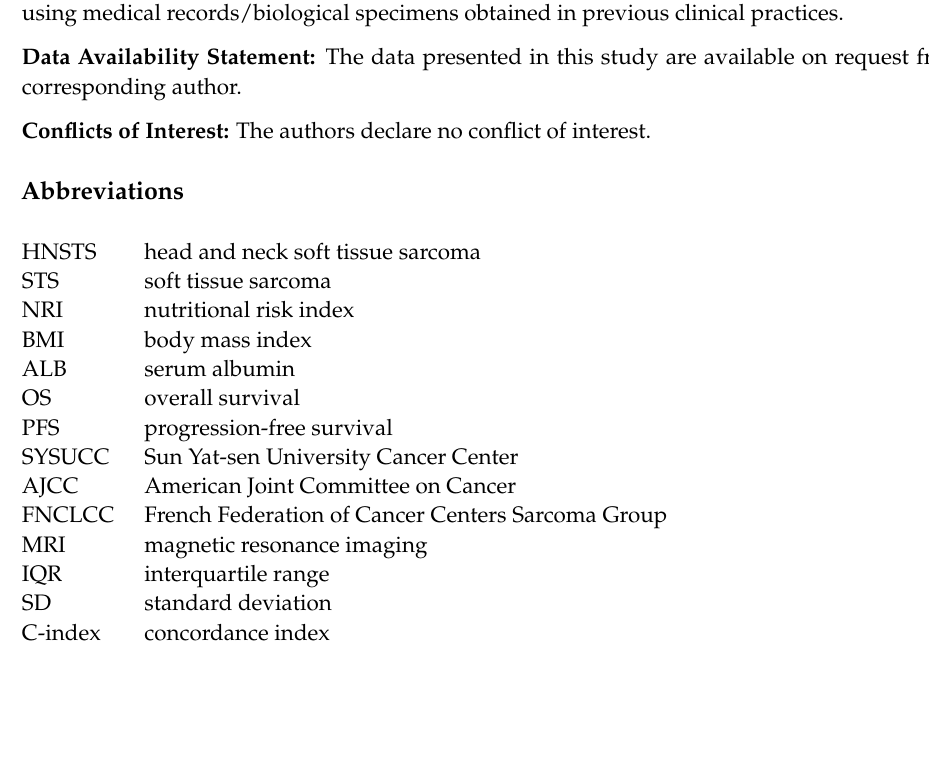
Figure S2: The maximum of the standardized log-rank statistics for NRI cut-off value; Figure S3: Calibration plot of OS (A) and PFS (B) at 3- and 5-year in the validation cohort; Figure S4: Predictive performance of nomogram for OS (A) and PFS (B) at 3- and 5-year, by time-dependent receiver operating characteristic (ROC) curve analysis; Figure S5: Progression-free survival (PFS) curves of subgroup analysis in HNSTS patients for different types of clinical manifestations according to NRI. (A) The PFS rate of patients with age ≤ 50; (B) The PFS rate of patients with age > 50; (C) The PFS rate of male patients; (D) The PFS rate of female patients; (E) The PFS rate of patients with low-risk site; (F) The PFS rate of patients with high-risk site; (G) The PFS rate of patients with surgery; (H) The PFS rate of patients with surgery and adjuvant therapy. NRI: nutritional risk index. Table S1: Univariate Cox regression analysis of factors associated with overall survival and progression-free